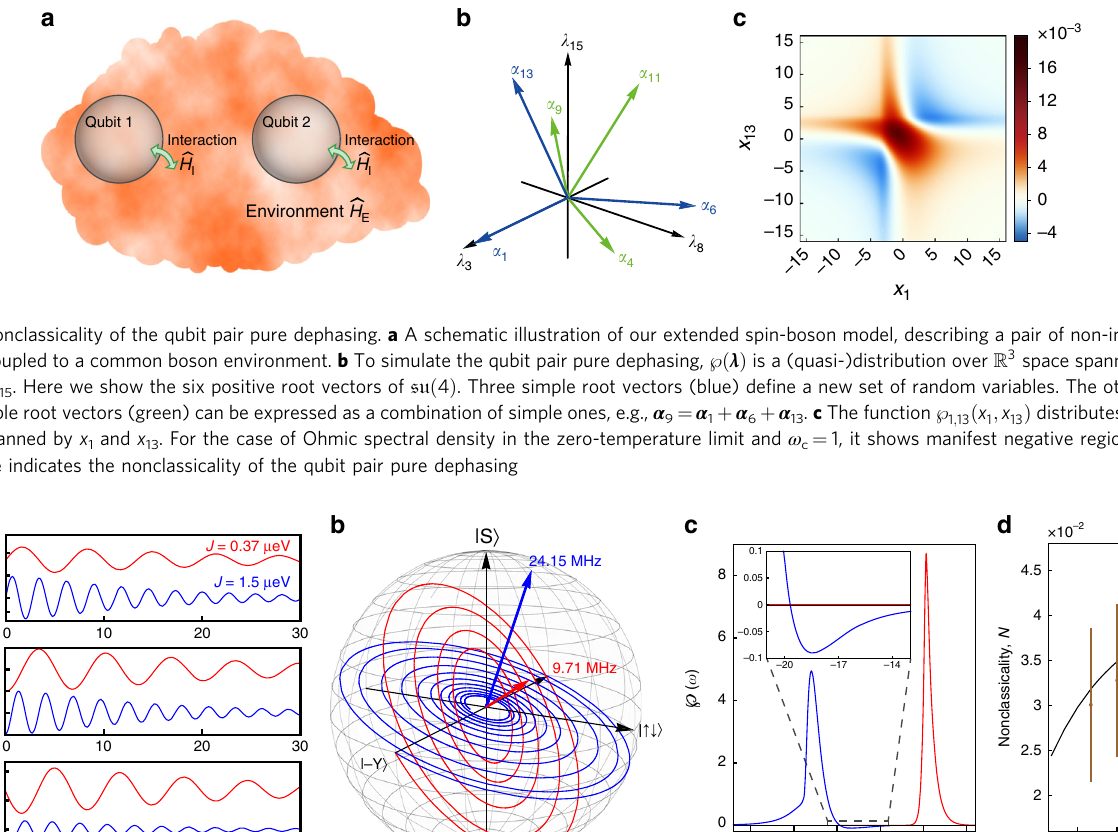
τ are measured by projecting the states onto each axis after a Fig. 4 Numerical simulation of the S-T 0 qubit pure dephasing. a The return probabilities P j j i s ð Þ free induction decay time τ s . Here, we show two numerical simulations at different J values. b The trajectories can be depicted in the Bloch sphere and the dynamics are therefore clearly visualized. The axes of rotation, as well as the angle Ω between the |S 〉 -axis, are identi fi ed by the normal vectors. c According to the rotation axes identi fi ed in ( b ), a unitary rotation b R Ω recovers the standard form in Eq. (2). Then our procedure is applicable. The resulting } ω ð Þ ’ s re fl ect several physical intuitions, as explained in the main text. d The corresponding nonclassicality N at different J can be estimated according to Eq. (4). It increases with J in our simulation. In line with a realistic experimental modeling, statistically fl uctuating noise is taken in account. The average nonclassicalities (brown dots) are reduced due to the noise. The brown error bars are the standard deviations of the series of nonclassicality N values obtained by repeatedly performing the noise simulation. More details are given in Supplementary Note